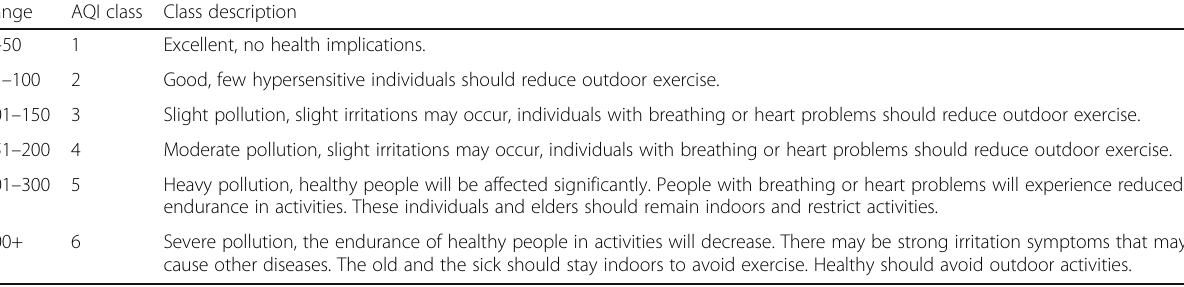
Table 2 AQI classes of China ’ s Ministry of Environmental Protection Range AQI class Class description